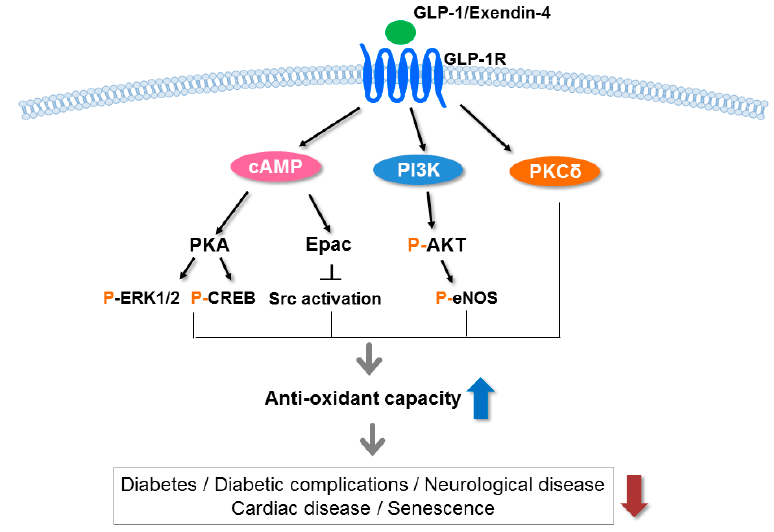
Figure 2. Signaling pathways underlying the antioxidative effects of the GLP-1 receptor. GLP-1 and exendin-4 (a GLP-1 receptor agonist) bind to the GLP-1 receptor (GLP-1R) and stimulate cyclic adenosine monophosphate (cAMP), phosphoinositide 3-kinase (PI3K) and protein kinase C (PKC) δ , subsequently activating a number of pathways including protein kinase A (PKA), exchange protein kinase activated by cAMP2 (Epac2) and protein kinase B (AKT). These pathways increase the antioxidant capacity in various tissues and reduce diabetes, diabetic complications, neurological disease, cardiac disease, and senescence. p, phosphorylation; ERK, extracellular signal-regulated kinase; CREB, cAMP response element binding protein; Src, sarcoma; eNOS, endothelial nitric oxide synthase 3. Nrf2 knockdown in a mouse insulinoma cell line (MIN6) or pancreatic islets isolated from Nrf2-